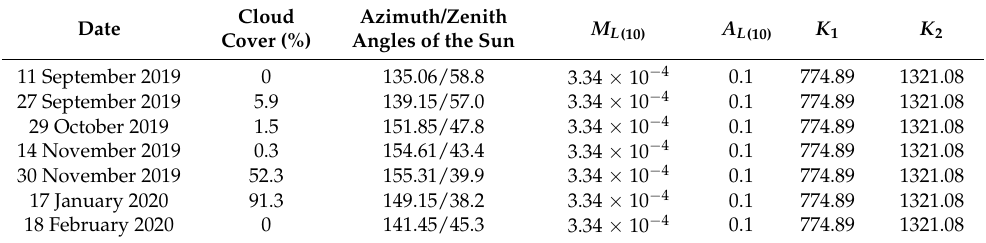
Figure 1. The location of the Liuxihe (LXH) watershed in Guangzhou province of China ( upper left ). The Guoyuan (GY) and Chenhe Dong (CHD) sampling sites in LXH watershed ( right ). The distribution of chambers in each study site, base map from Google Earth ( lower left ). Table 1. Metadata for Landsat 8